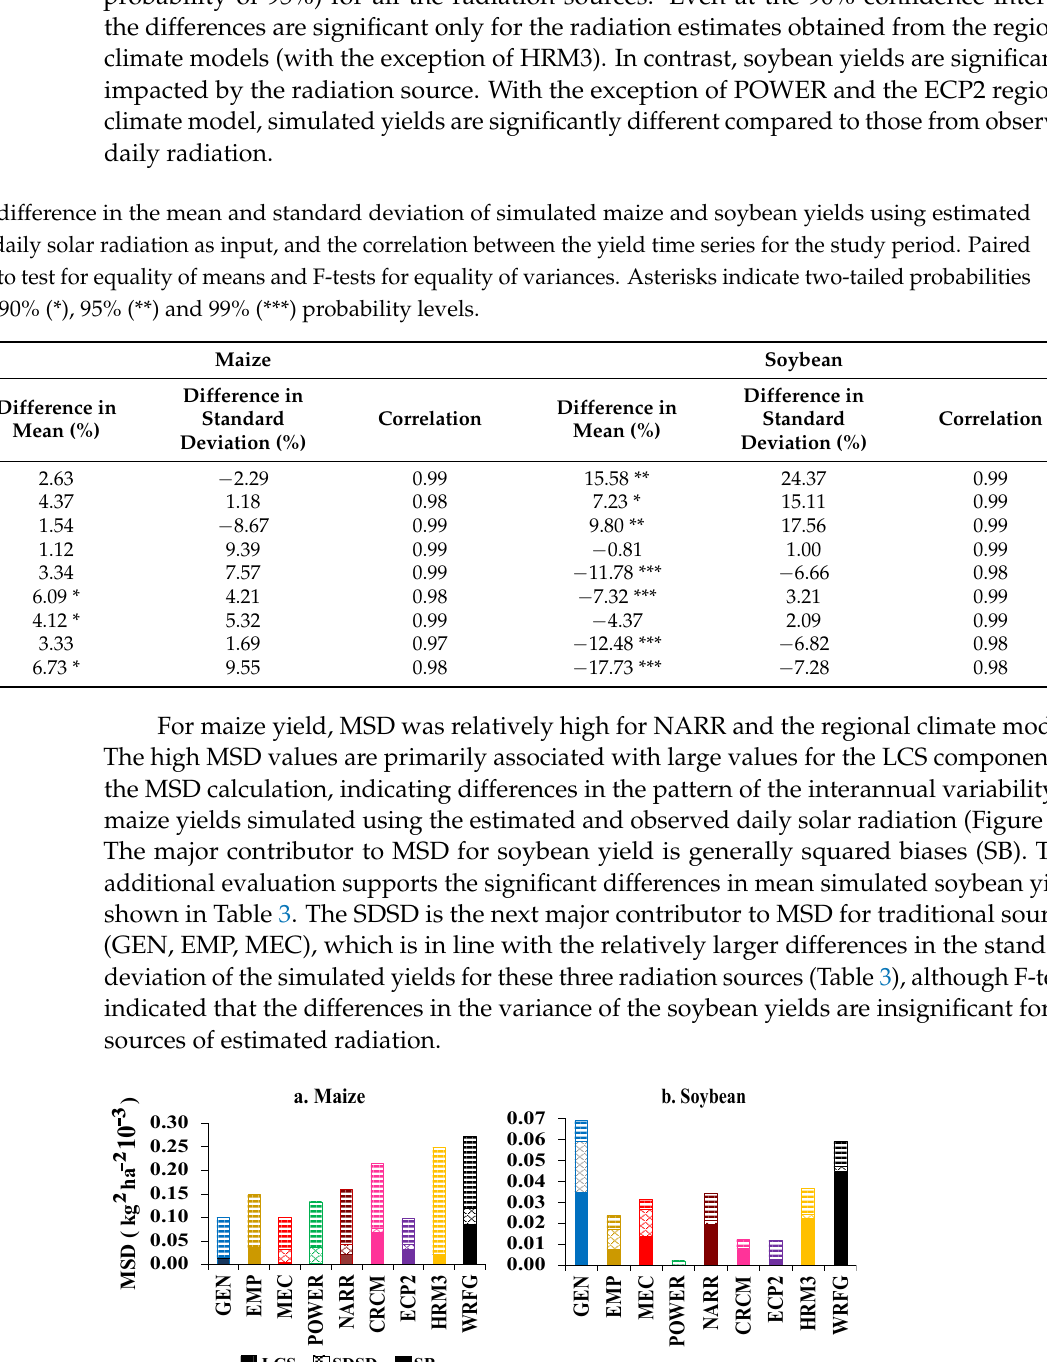
Figure 14. Mean squared deviation (MSD), squared bias (SB), squared difference between standard deviation (SDSD) and the lack of correlation weighted by the standard deviation (LCS) for maize ( a ) and soybean ( b ) yield simulated using daily solar radiation estimates compared to yield simulations using radiation observations. Please note the difference in the vertical axes for the two plots, reflecting the higher yields for maize compared to soybean. See Figure 2 for definitions of the abbreviations, and Section 2.4.3 for an explanation of MSD and its components.